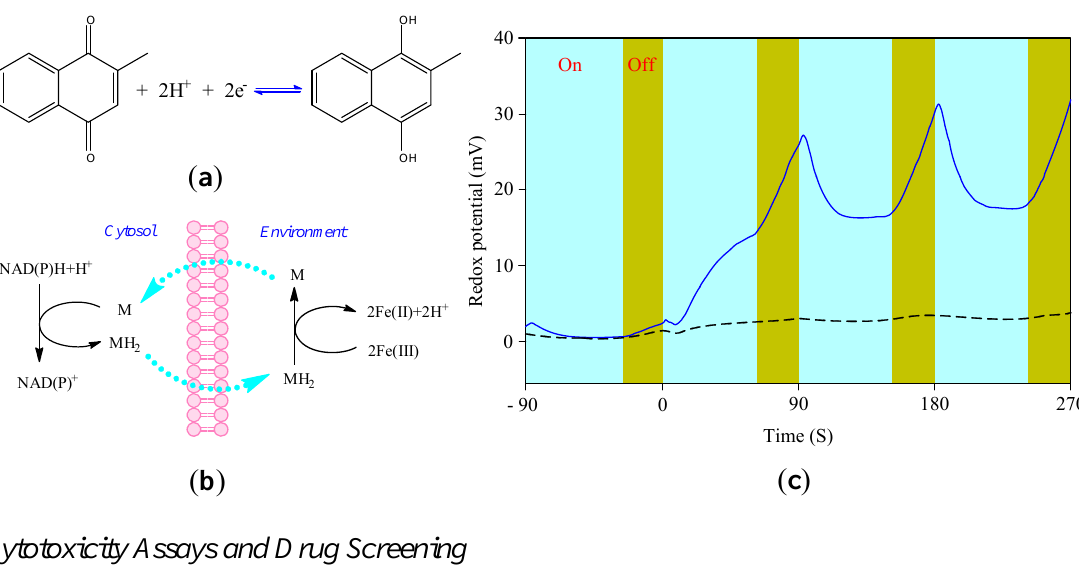
Figure 20. Detection of cellular redox reactions with use of menadione to link intra- and extra-cellular redox pairs. ( a ) Two-electron reduction of menadione to menadiol; ( b ) Hypothetical menadione reaction cycle; ( c ) Potentiometric measurements of menadione mediated ferricyanide reduction by cells. (Reproduced with permission from [51]. © 1998 American Chemical